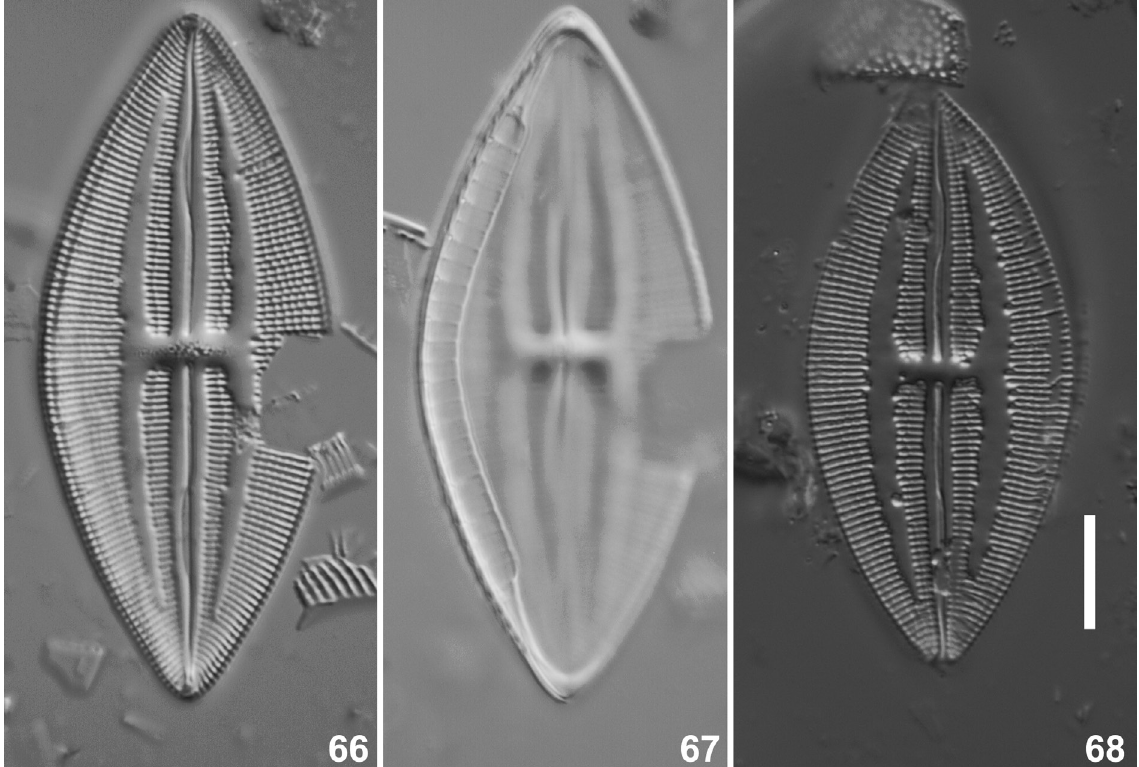
Figs 66–68. Mastogloia baldjikiana Grunow. Light micrographs (LM) of valves from slide 545 (Baldjick, Types du Synopsis des diatomées de Belgique, Van Heurck collection, BR). 66–67 . Same valve taken at different foci. 66, 68 . LM views of 2 valves showing variation in valve size and shape. 67 . LM view of the partectal ring with the partecta. Scale bar: 10